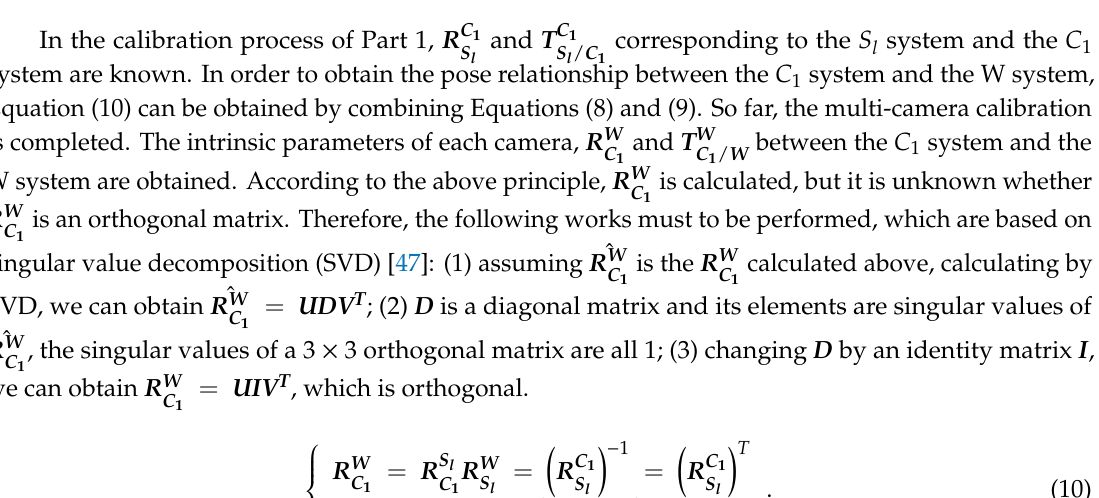
Figure 3. The location and principle of the special checkerboard: ( a ) relationship of the rotation matrix; ( b ) relationship of the translation vector.